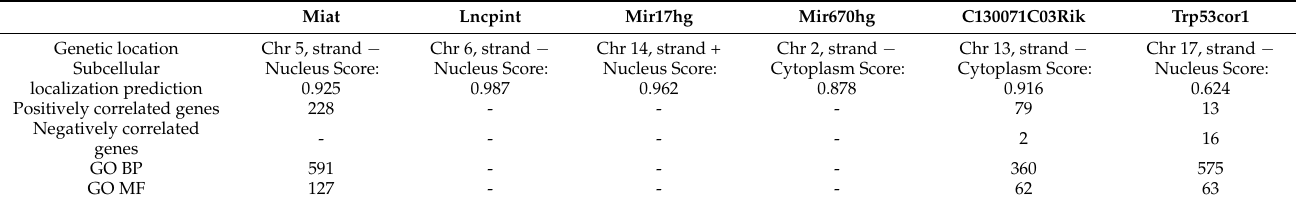
Table 2. Characterization of lncRNAs with human homologues. Genomic location, subcellular localization, the number of positively and negatively correlated genes (co-expression), and the number of functional annotations for lncRNAs with human homologue. Subcellular localization was predicted through the LncLocator tool [54], whereas Genetic location as well as co-expression and functional annotation were obtained through the AnnoLnc2 database [55] (adapted from http://annolnc.gao-lab.org (accessed on 8 July